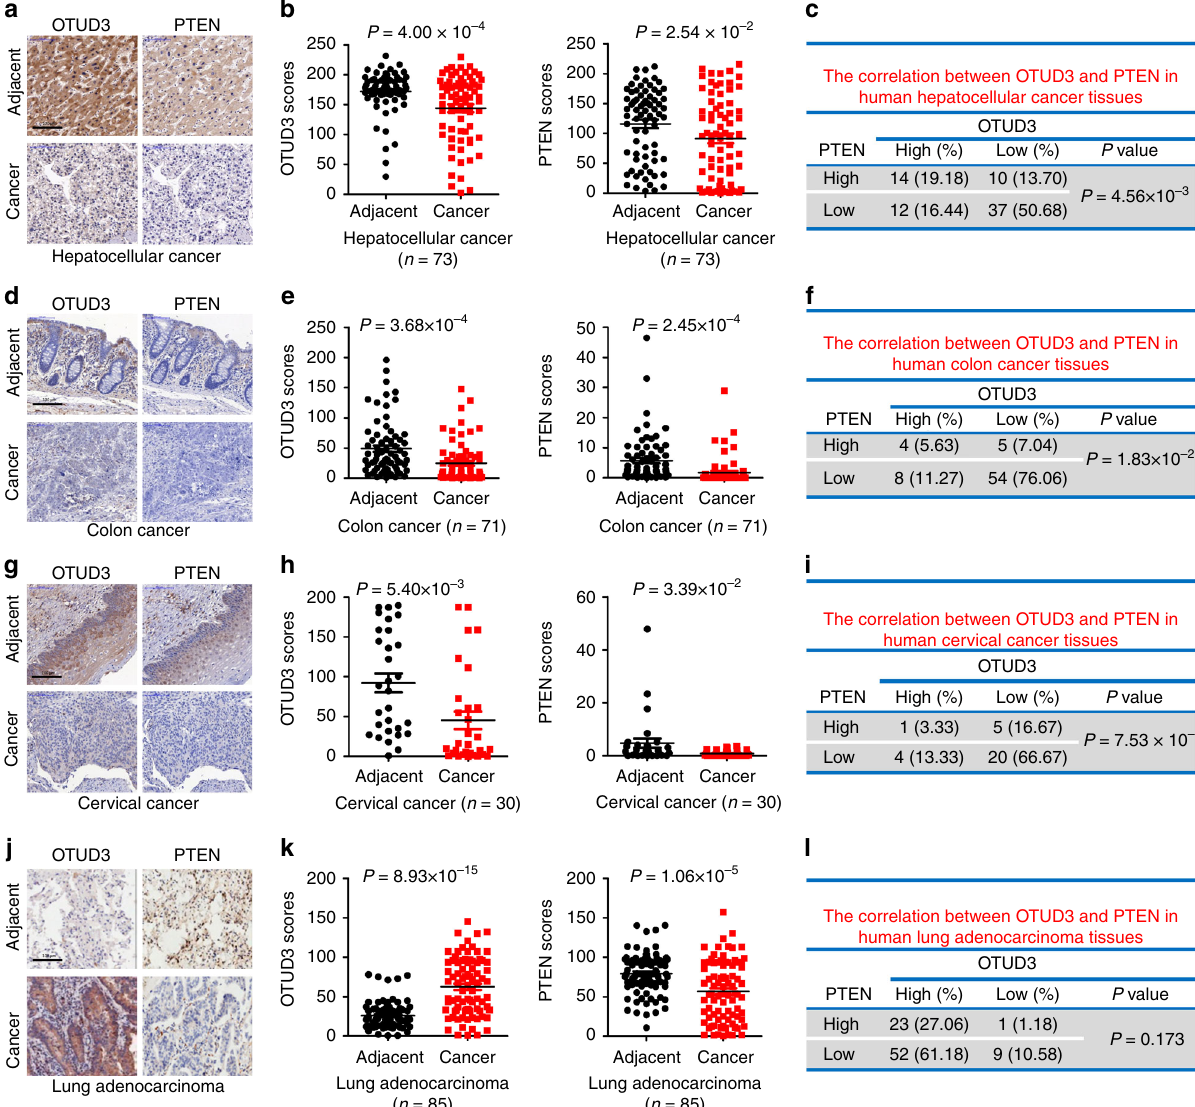
Fig. 2 Analysis of the association between OTUD3 and PTEN in cancer. a Representative images from immunohistochemical staining of OTUD3 and PTEN in hepatocellular carcinoma ( n = 73) and matched adjacent tissue (scale bar, 100 μ m). b OTUD3 and PTEN protein levels in cancer tissues are compared with matched adjacent normal tissues in hepatocellular carcinoma by using a Wilcoxon matched pairs test. c The correlation of OTUD3 with PTEN protein levels was analyzed in Human Hepatocellular Cancer Tissues. d Representative images from immunohistochemical staining of OTUD3 and PTEN in Colon cancer ( n = 71) and matched adjacent tissue (scale bar, 100 μ m). e OTUD3 and PTEN protein levels in cancer tissues are compared with matched adjacent normal tissues in Colon cancer by using a Wilcoxon matched pairs test. f The correlation of OTUD3 with PTEN protein levels was analyzed in Human Colon Cancer Tissues. g Representative images from immunohistochemical staining of OTUD3 and PTEN in Cervical carcinoma ( n = 30) and matched adjacent tissue (scale bar, 100 μ m). h OTUD3 and PTEN protein levels in cancer tissues are compared with matched adjacent normal tissues in Cervical carcinoma by using a Wilcoxon matched pairs test. i The correlation of OTUD3 with PTEN protein levels was analyzed in Human Cervical Cancer Tissues. j Representative images from immunohistochemical staining of OTUD3 and PTEN in Lung adenocarcinoma ( n = 85) and matched adjacent tissue (scale bar, 100 μ m). k OTUD3 and PTEN protein levels in cancer tissues are compared with matched adjacent normal tissues in Lung adenocarcinoma by using a Wilcoxon matched pairs test. l The correlation of OTUD3 with PTEN protein levels was analyzed in Human Lung Adenocarcinoma Tissues. The samples were classi fi ed into two groups (low OTUD3, high OTUD3) based on the OTUD3 level relative to the scores of the whole cohort. Data were analysed using Mann – Whitney test ( c , f , i , l ). Statistics source data can be found in Supplementary Data